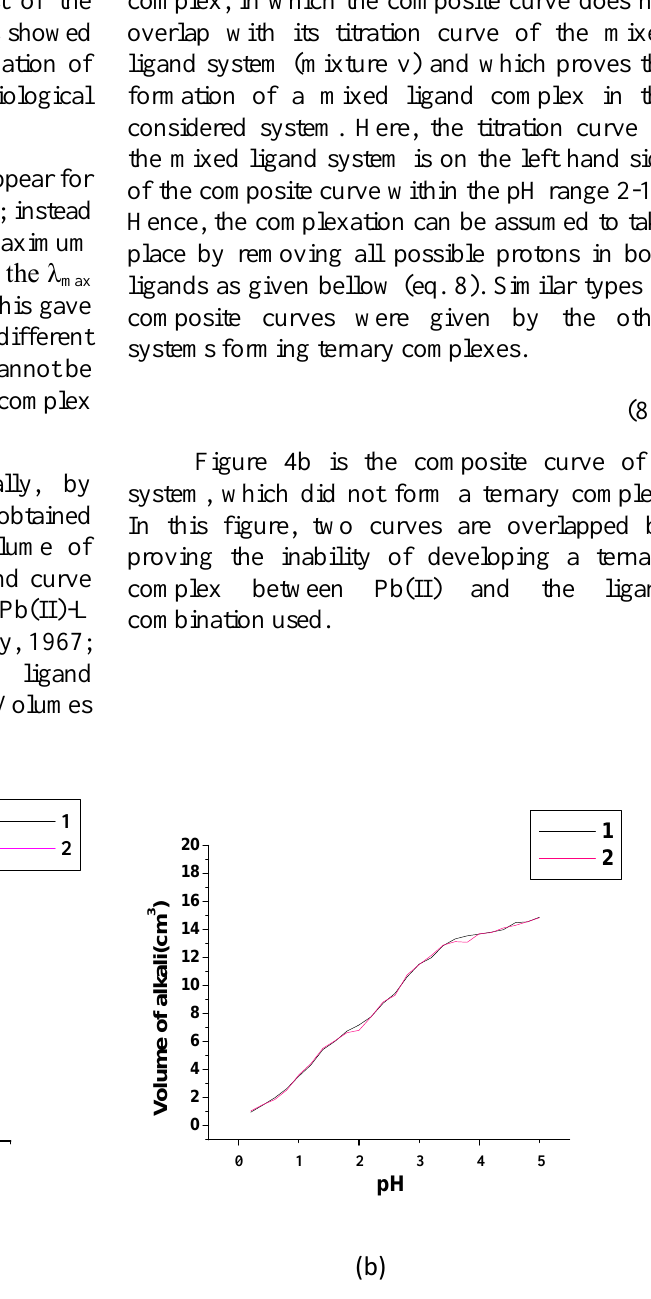
Figure 4: (a) : Composite curve (2) and mixed ligand titration curve (1) for Pb(EDTA-Vit B system .(b) Composite curve (2) and mixed ligand titration curve (1) for Pb(Sali+Vit B